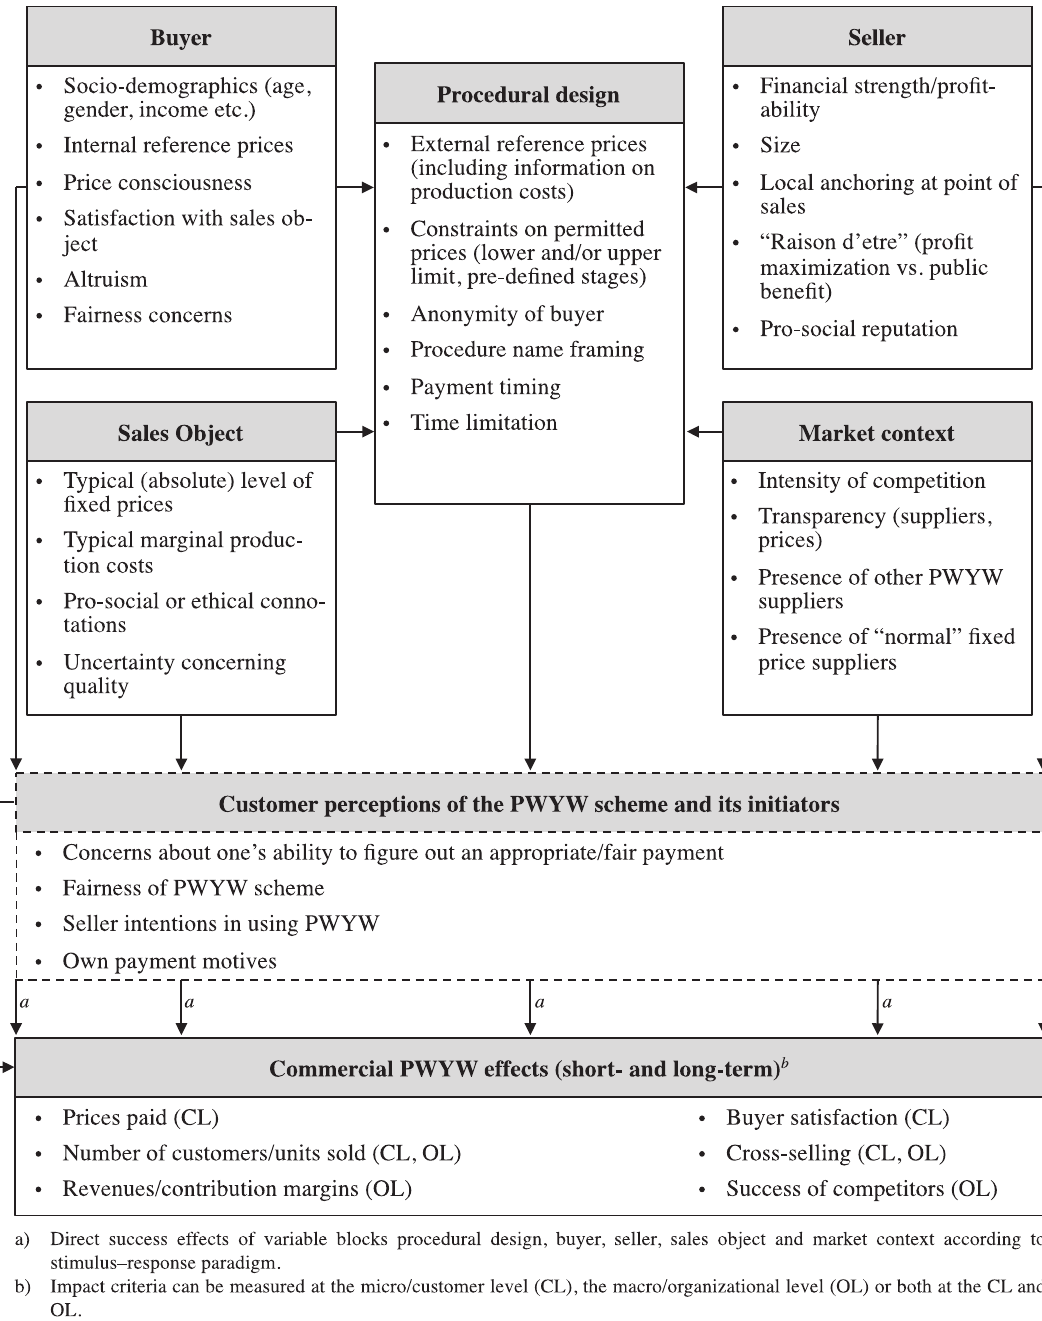
Fig. 2. Conceptual framework of the most important variable categories and interconnections in the PWYW research